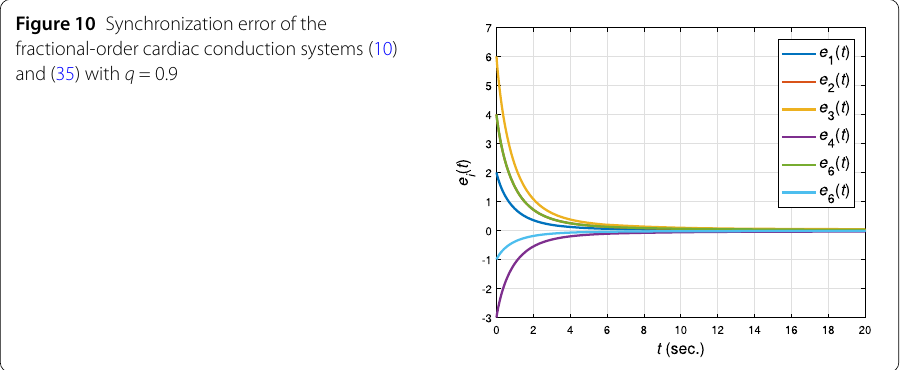
Figure 10 Synchronization error of the fractional-order cardiac conduction systems (10) and (35) with q =